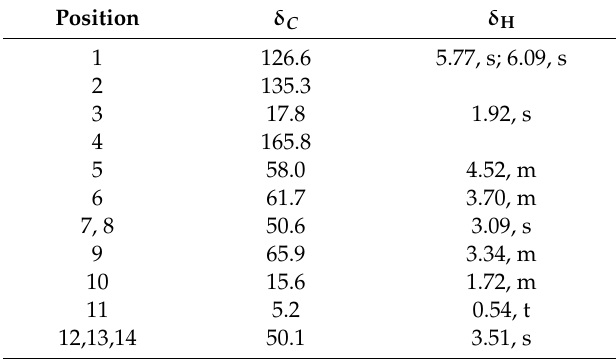
Figure 2. 1 H-NMR spectra of AMsil1 ( a ) and AMsil2 ( b ) products. Table 3. NMR spectral peak assignments of AMsil1 structure.